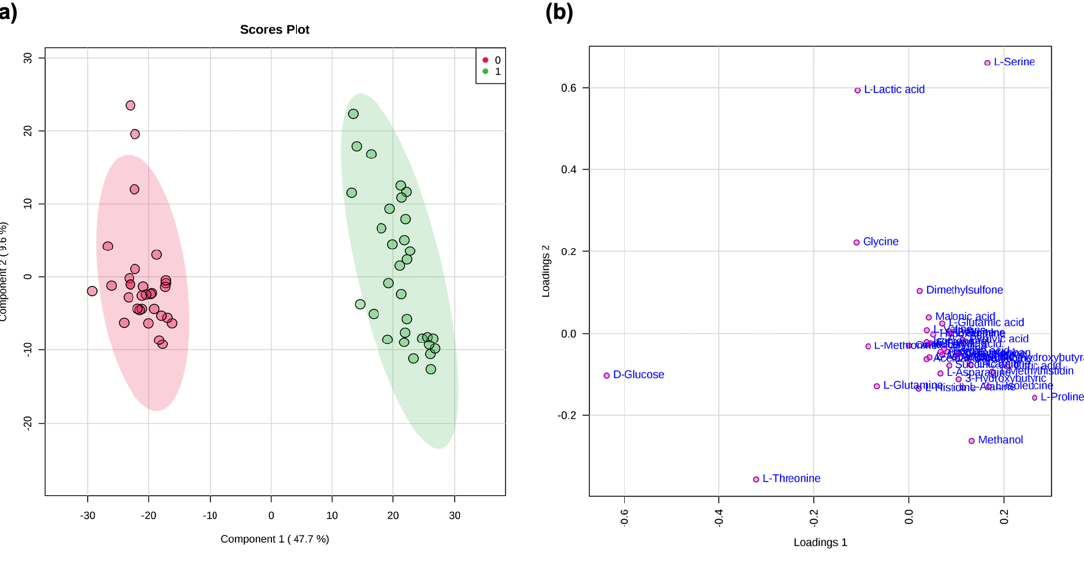
Figure 2. PLS-DA score scatter plot ( a ) and PLS-DA loading scatter plot ( b ) for the 1 H NMR data collected in 1D-1H-CPMG spectra acquired at 600 MHz. Data represent the sera from 31 controls (0, red) and 30 fibromyalgic patients (1, green).